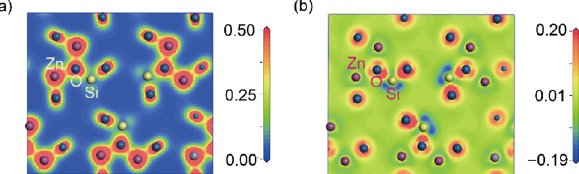
Distributions of charge density on the (001) crystal plane of Zn 2 SiO 4 . (a) Distribution of valence charge density in the energy range from − 6.3 to − 4.5 eV and (b) differential charge density